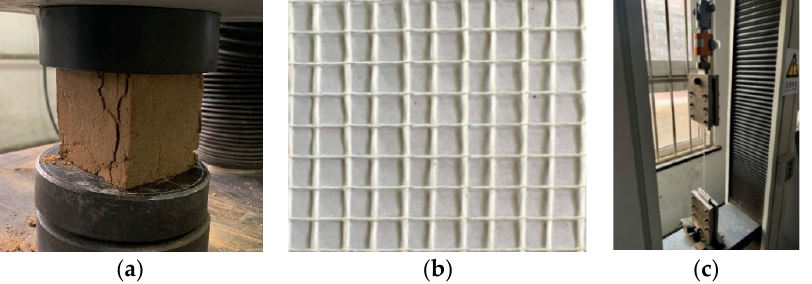
Figure 1. Flowchart.